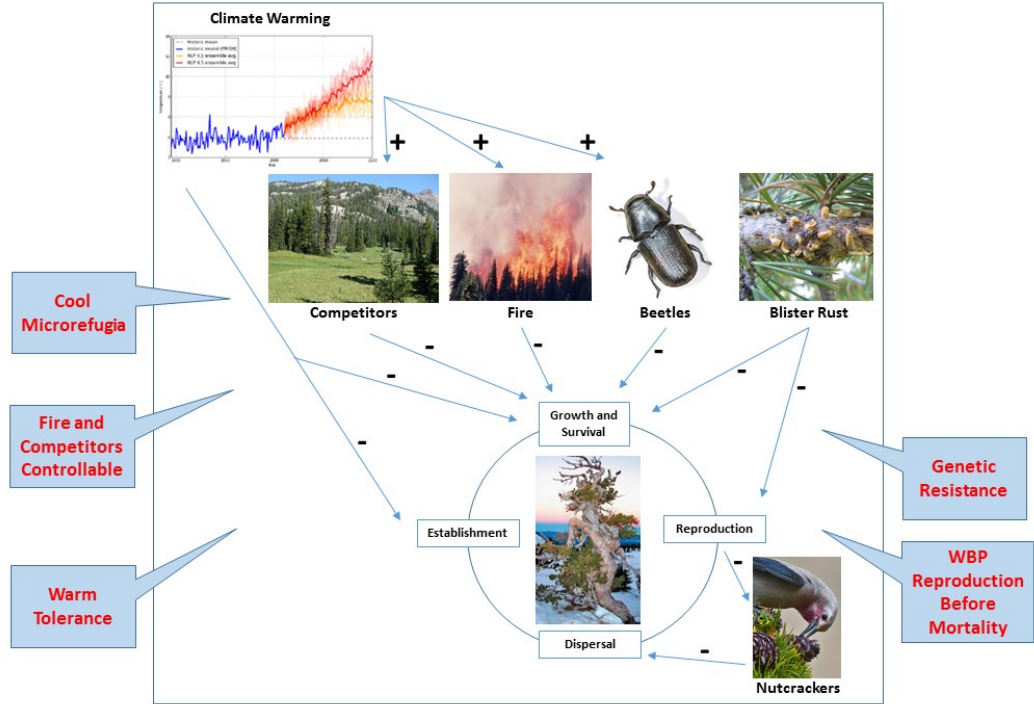
Figure 1. (Inner box) Conceptual model of the projected direct and indirect effects of climate warming on WBP demography based on the current literature. Positive and negative signs denote the nature of the effect. Climate warming reduces whitebark pine (WBP) establishment, growth, and survival directly by exceeding WBP physiological tolerances and indirectly by favoring competing vegetation, severe fire, and mountain pine beetles. White pine blister rust negatively influences WBP growth, survival, and reproduction. However, the influence of climate change on white pine blister rust in the Greater Yellowstone Ecosystem (GYE) is not currently understood. (Outer Box) Ecological mechanisms that may allow WBP to remain viable in GYE in the face of projected climate warming and related threats (red text in call-out boxes). Picture and figure credits from left to right and top to bottom are: Tony Chang, Andrew Hansen, Yellowstone National Park Photo Archive, Colleen Kimmett, Grav Skeldon, Louisa Willcox, Karen Rentz.